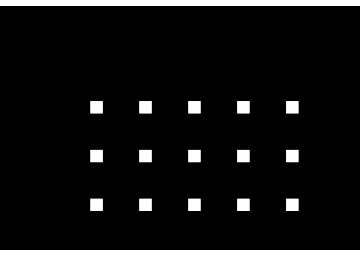
Figure 5. The HSI image of Lake Salvador